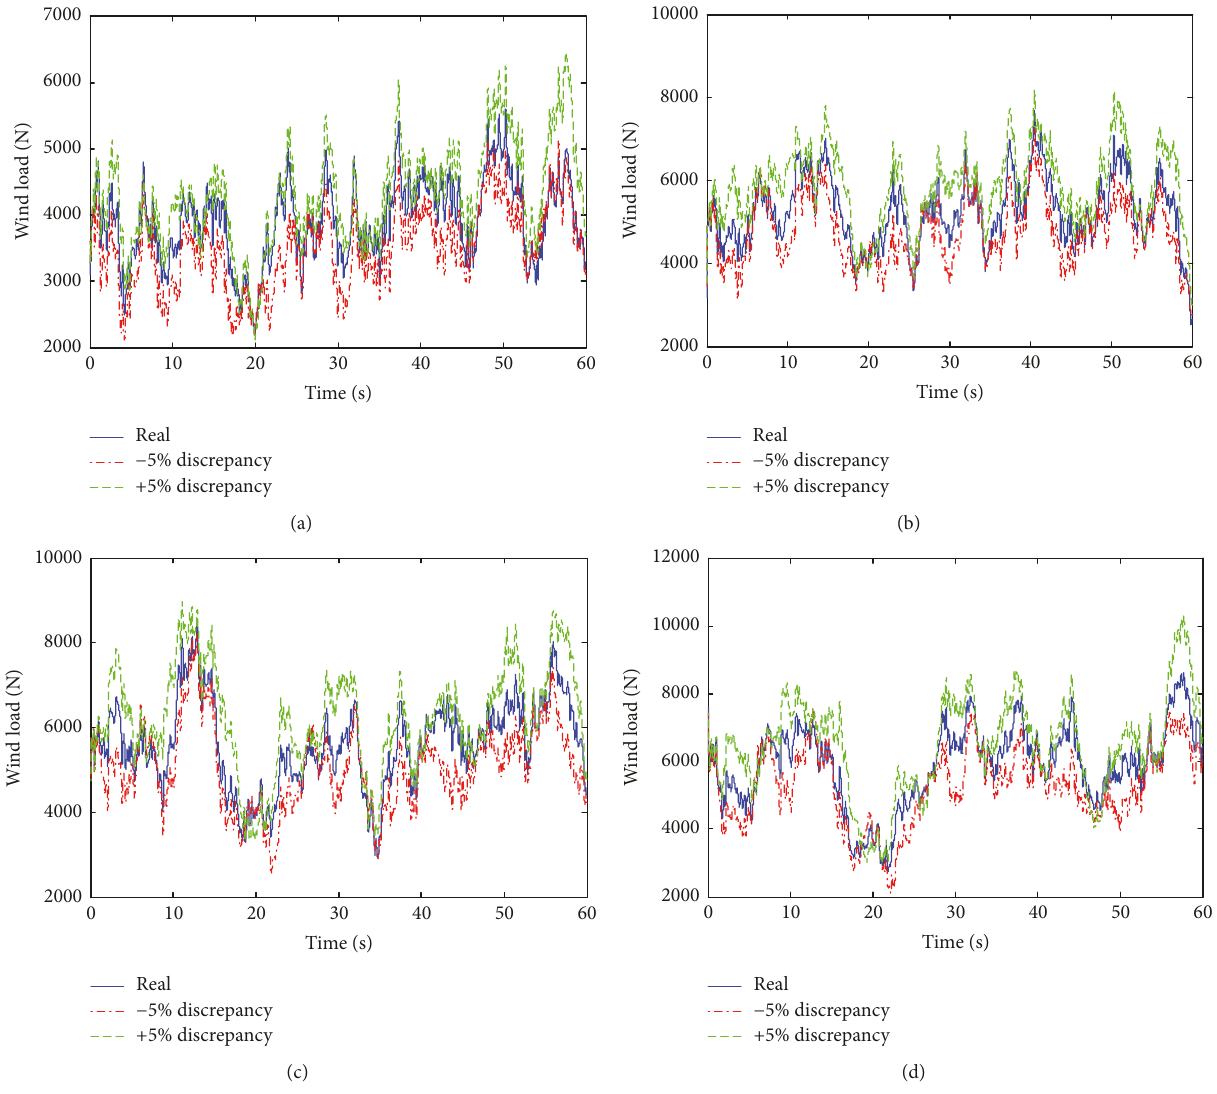
Figure 8: The histories of the estimated wind load with ± 5% discrepancy in natural frequencies. (a) On the 5th floor; (b) on the 10th floor; (c) on the 15th floor; (d) on the 20th